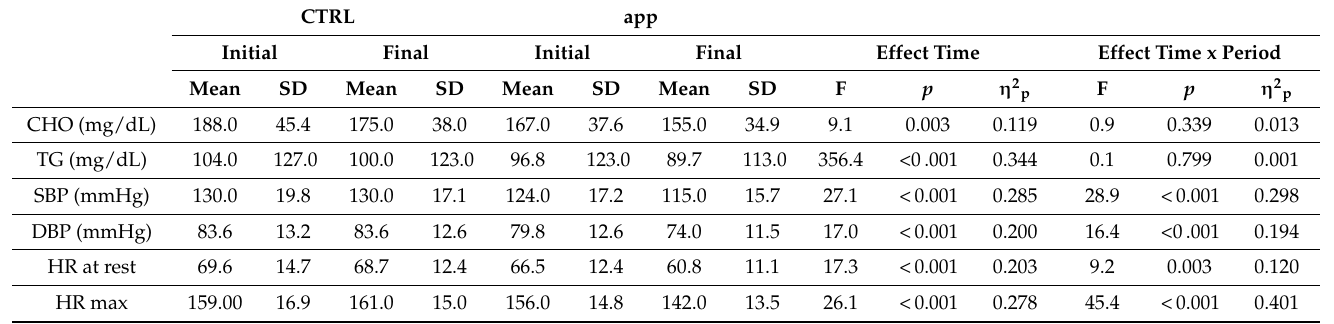
Table 5. Descriptive data (mean ± standard deviation) of cardiovascular parameters. Effect of the intervention (ANOVA) on blood pressure